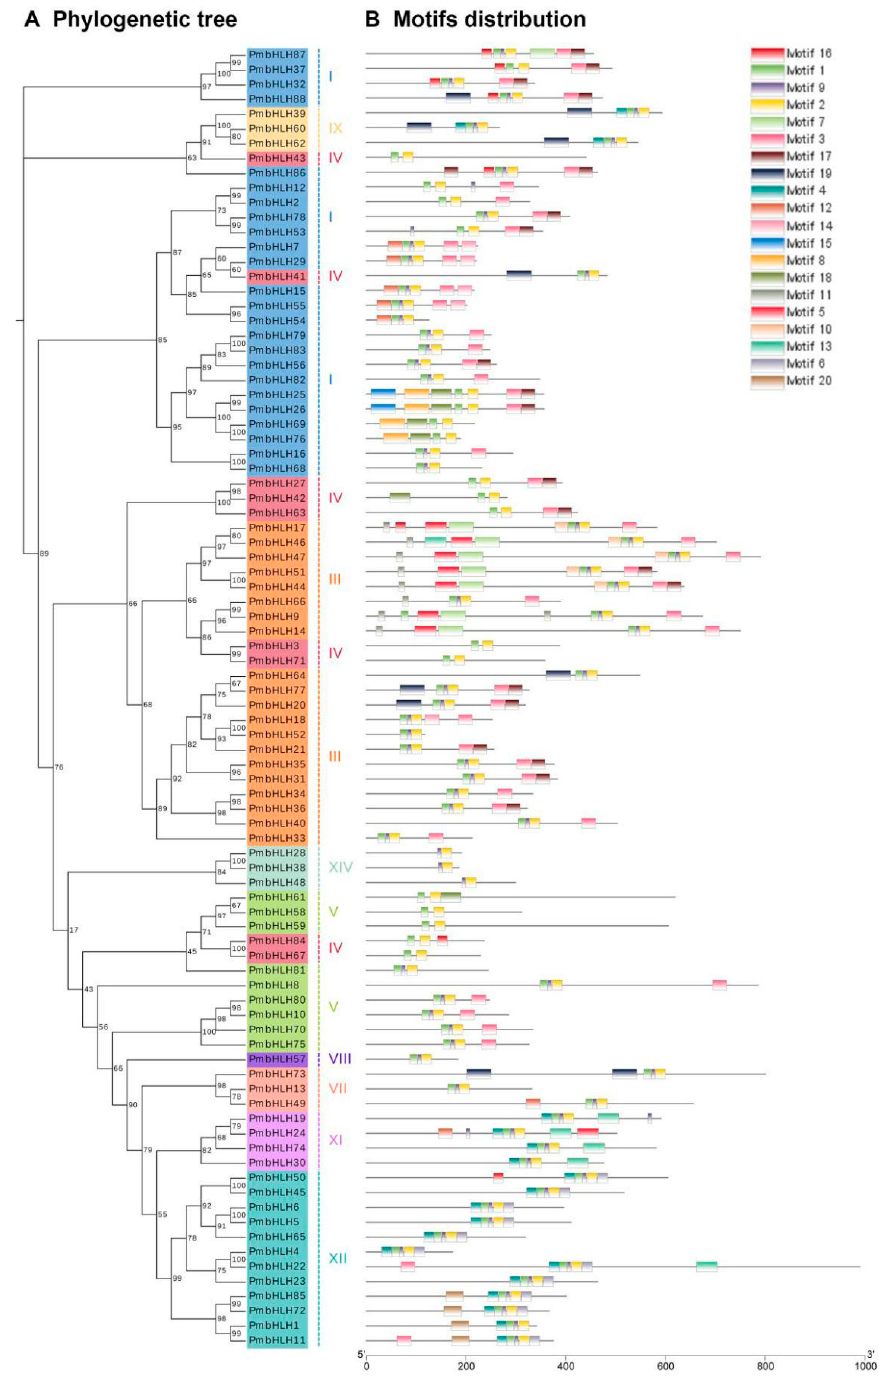
Figure 2. Phylogenetic analysis and motif distribution of bHLH proteins in P. massoniana . ( A ) The phylogenetic tree constructed for 88 PmbHLH proteins. ( B ) The conserved motifs of each protein as identified by MEME. The 20 different colors represent 20 different conserved motifs.